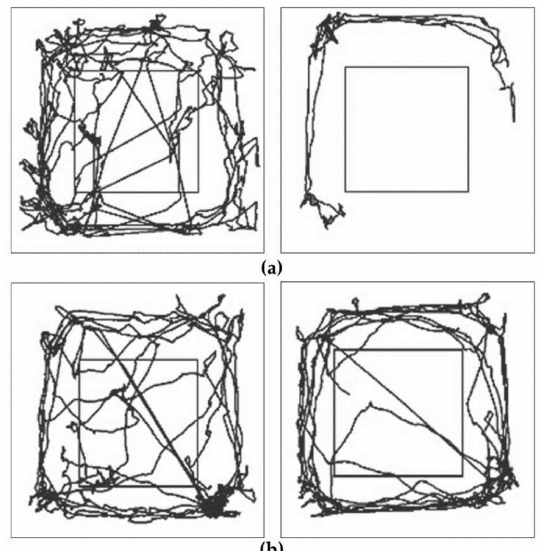
Figure 2. Distance covered in a representative 6-OHDA-treated control ( a ) and enriched animal ( b ); evaluated with Smart Junior program (Panlab, Harvard Apparatus, Barcelona, Spain). Movement of the animals was followed before ( left panels ) and 10 days after the operation ( right panels ).